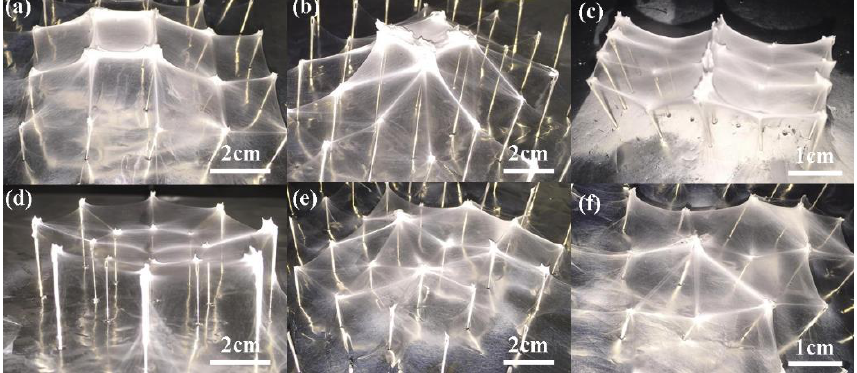
Figure 9. 3D nanofibrous structures printed on probe arrays with non-uniform probe heights. ( a , b )